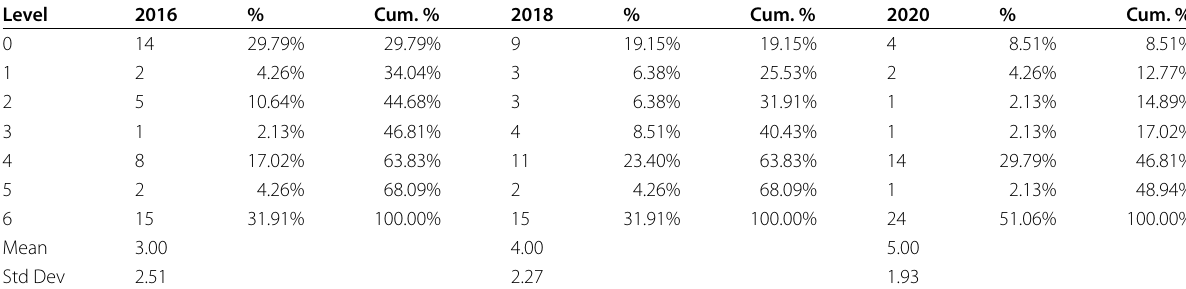
Table 2 Summary of Results (2016 to 2020)